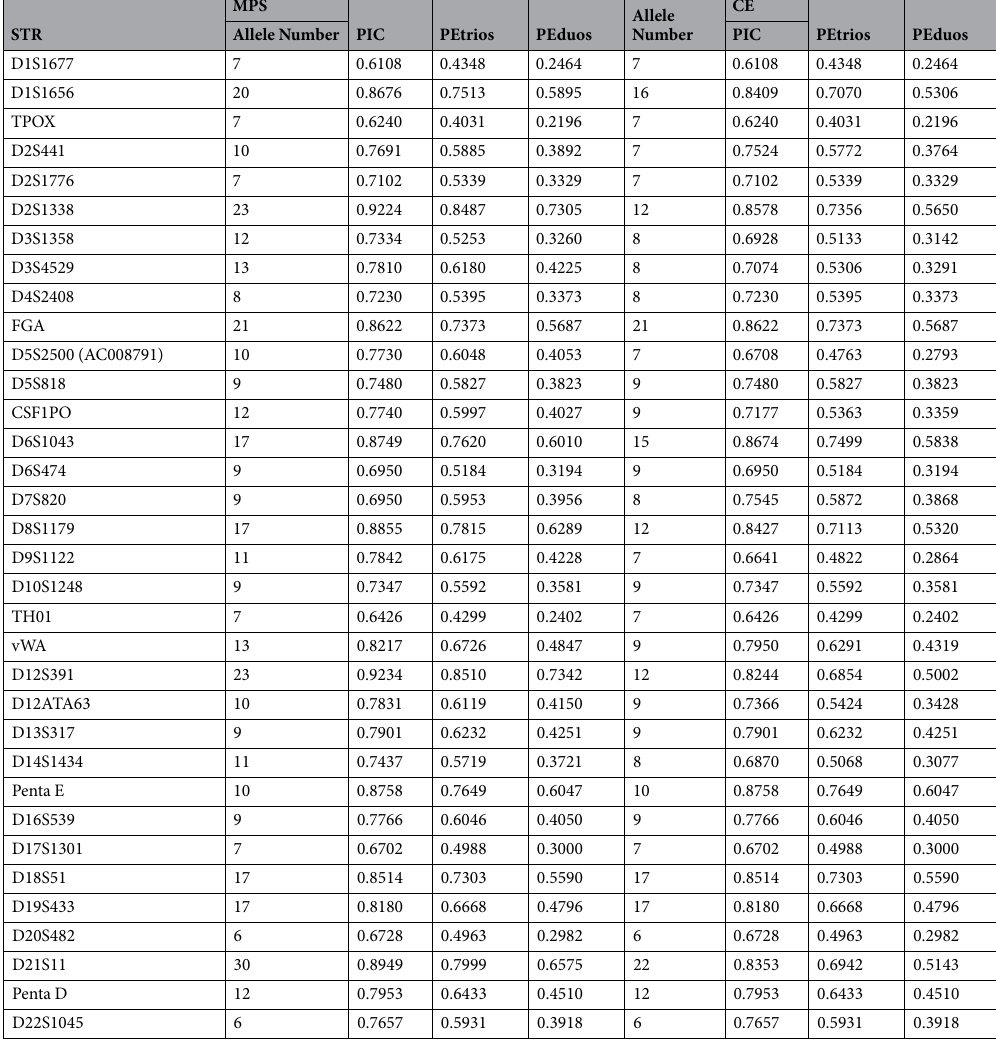
Table 1. Detected alleles and corresponding forensic parameters of the 34 STRs via MPS and CE detection (N =